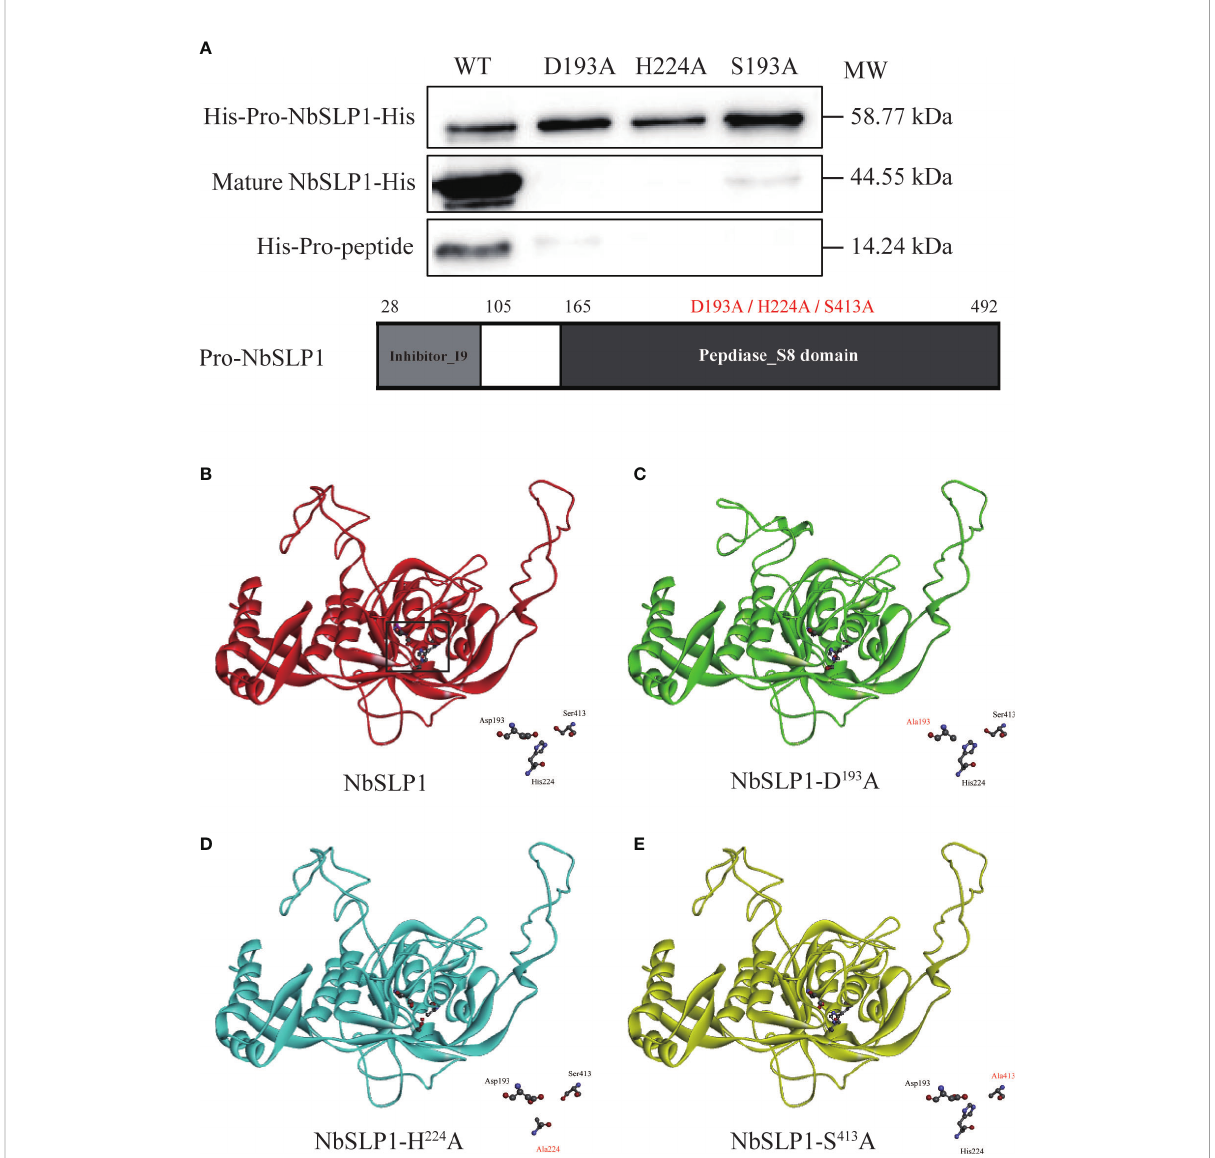
FIGURE 5 Autoproteolysis analysis of Pro-NbSLP1 mutants of active sites and predicted 3D structure. (A) Western blot analysis of Pro-NbSLP1 mutants in active sites. Supernatant from induced E . coli BL21 (DE3) [pET30- pro - Nbslp1 ] (WT), E . coli BL21 (DE3) [pET30- pro - Nbslp1-D193A ](D193A), E. coli BL21 (DE3)[pET30- pro - Nbslp1-H224A ](H224A), E . coli BL21 (DE3) [pET30- pro - Nbslp1-S413A ](S413A) were analyzed by immunoblotting using His antibody. Details were showed below. Predicted 3D structure of NbSLP1 and its mutants against Pro-subtilisin E are showed in B – E ; unmutated NbSLP1 is showed in red ribbon (B) , NbSLP1-D193A is showed in green ribbon (C) , NbSLP1-H224A is showed in blue ribbon (D) , NbSLP1-S413A is showed in yellow ribbon (E) ; catalytic triads were showed in bottom right of each